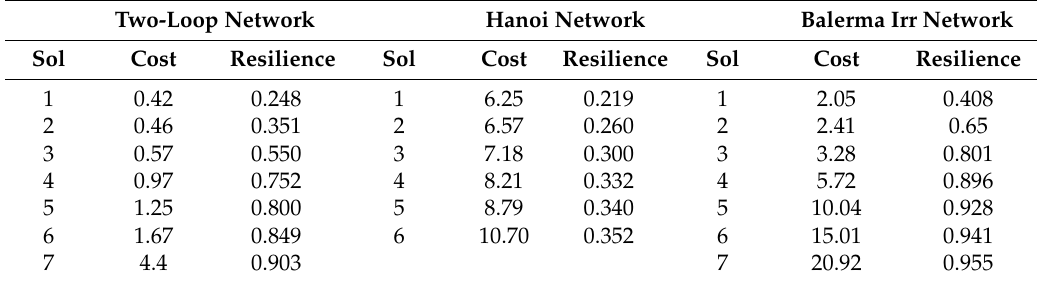
Figure 5. Pareto fronts of the BIN. Table 5. Solutions for each